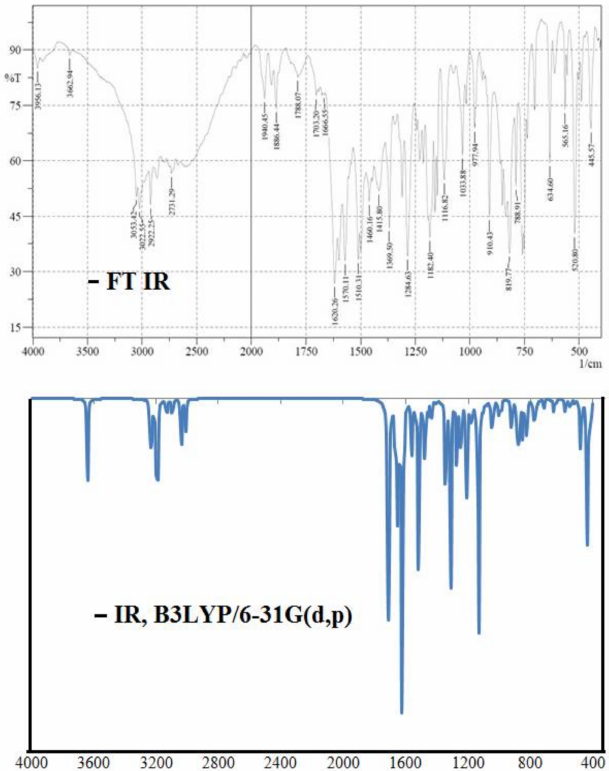
Figure 1. Comparison of experimental and simulated IR spectra of ligand,